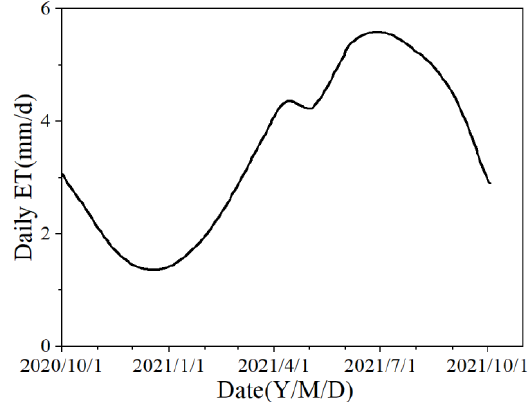
Figure 15. Variation in daily ET during the crop-growing season.